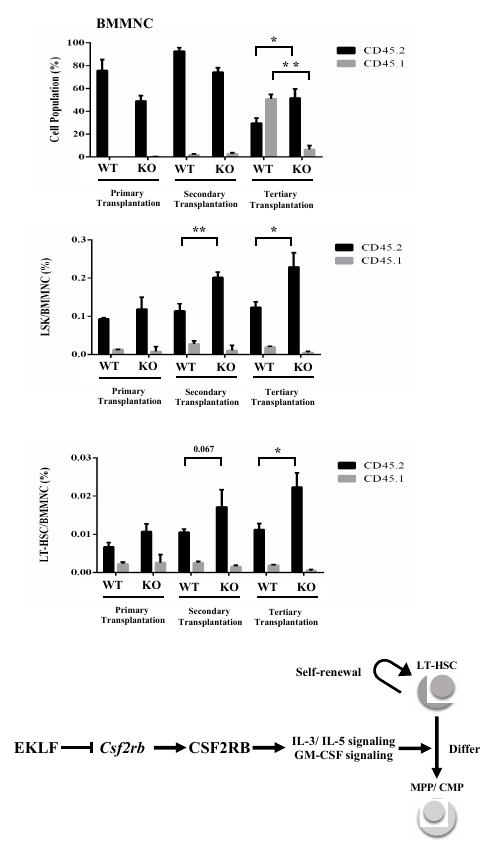
Figure 4. ( A ) FACS analysis of BMMNCs, Lin − Sca1 + c-Kit + (LSK) cells, and Flk2-CD34-HSCs in the bone marrow of recipient mice after serial transplantation. The bone marrow cells were stained with the appropriate antibodies and analyzed by FACS. Statistical analysis of the FACS data. The percentages of BMMNCs, ratios of LSK cells/BMMNCs, and ratios of Flk2-CD34-HSCs/BMMNCs in the bone marrows of primary, secondary, and tertiary recipient mice, as deduced from the FACS data,